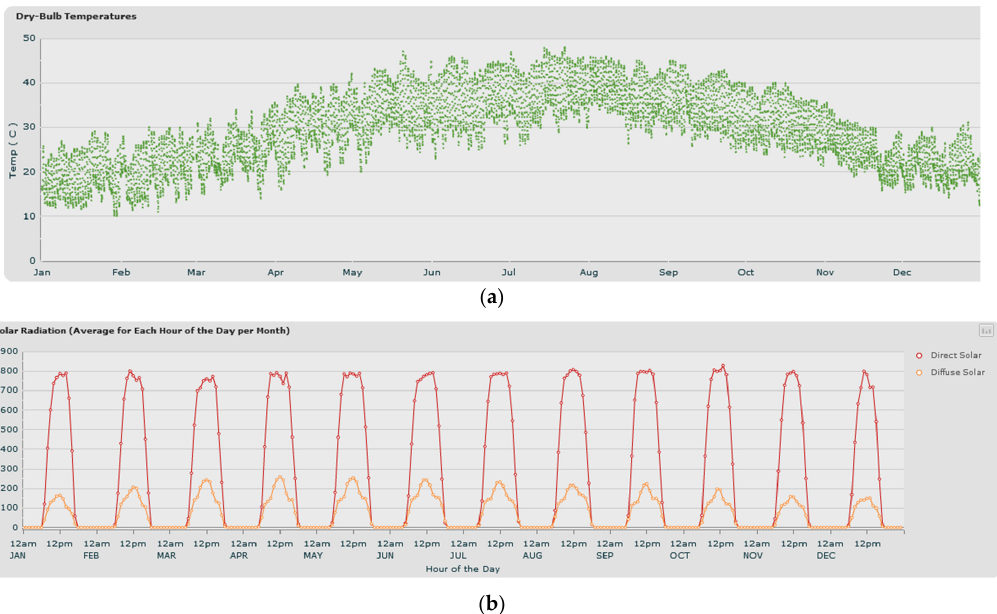
Figure 1. Annual weather data for Al Ain, UAE. ( a ) Annual hourly temperature data for Al Ain, UAE (source: Al Ain Airport); ( b ) Solar Radiation data (source: Al Ain Airport).